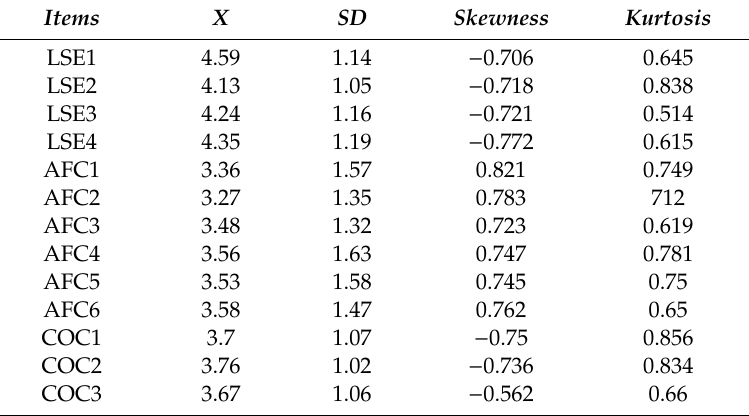
Table 3. Normality test for the